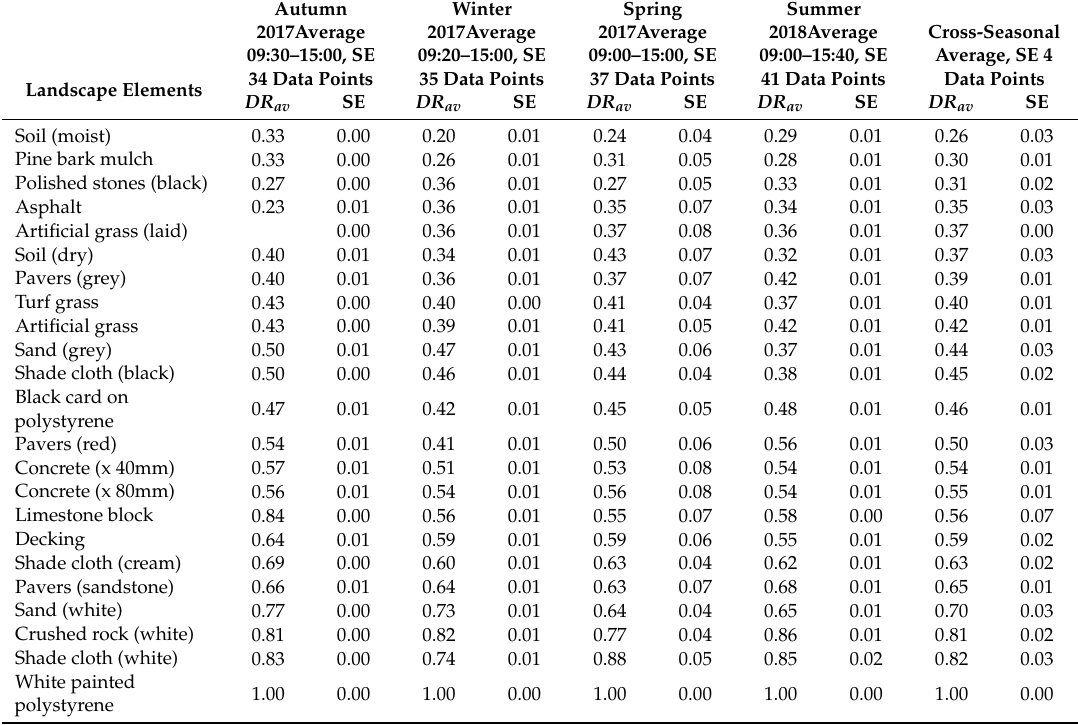
Table A2. Average daytime ratio DR av , (the ratio of the black iButton temperature for each LE minus the ambient temperature, over the black iButton temperature of the WPP minus the ambient temperature). SE is the standard error. Data are ordered by cross-seasonal